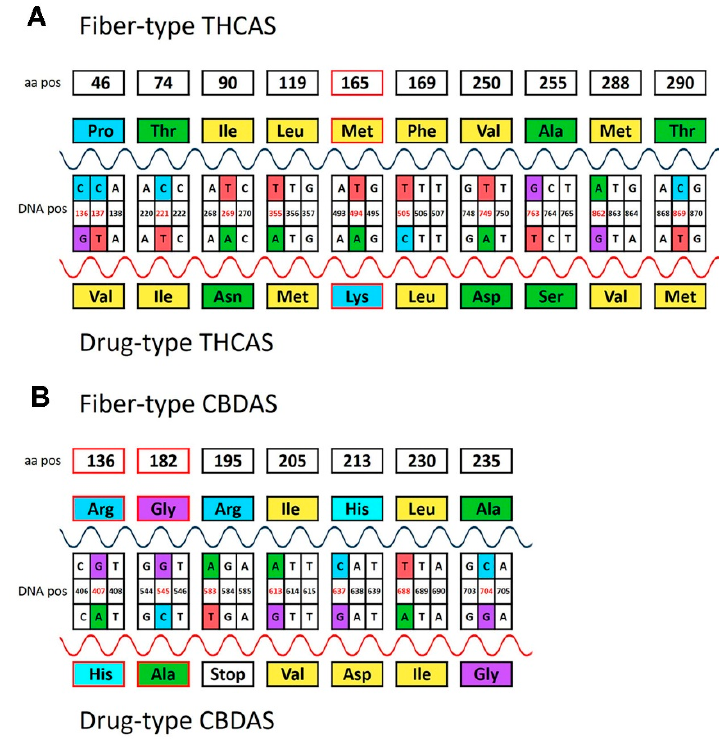
Figure 4. Polymorphisms of the nucleotide sequence of tetrahydrocannabinolic acid synthase ( THCAS ) ( A ) and cannabidiolic acid synthase ( CBDAS ) ( B ) causing amino acid changes in the primary structure of the protein of fiber-type and drug-type genotypes. The diagram shows the amino acid changes involving neutral (black box) and deleterious (red box) mutations of the protein sorted from PROVEAN analysis.